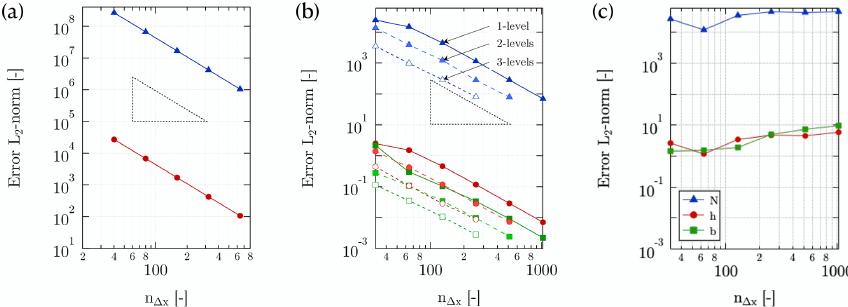
Figure 3. Convergence results for (a) the distributed test case, (b) the channelized test case with the diffusion term and (c) the original channelized test case without diffusion. The variables shown are the effective pressure ( N ) in blue, the head ( h ) in red and the gap height ( b ) in green. The x axis is the number of cells in the computational domain in the x direction, n (cid:49)x .